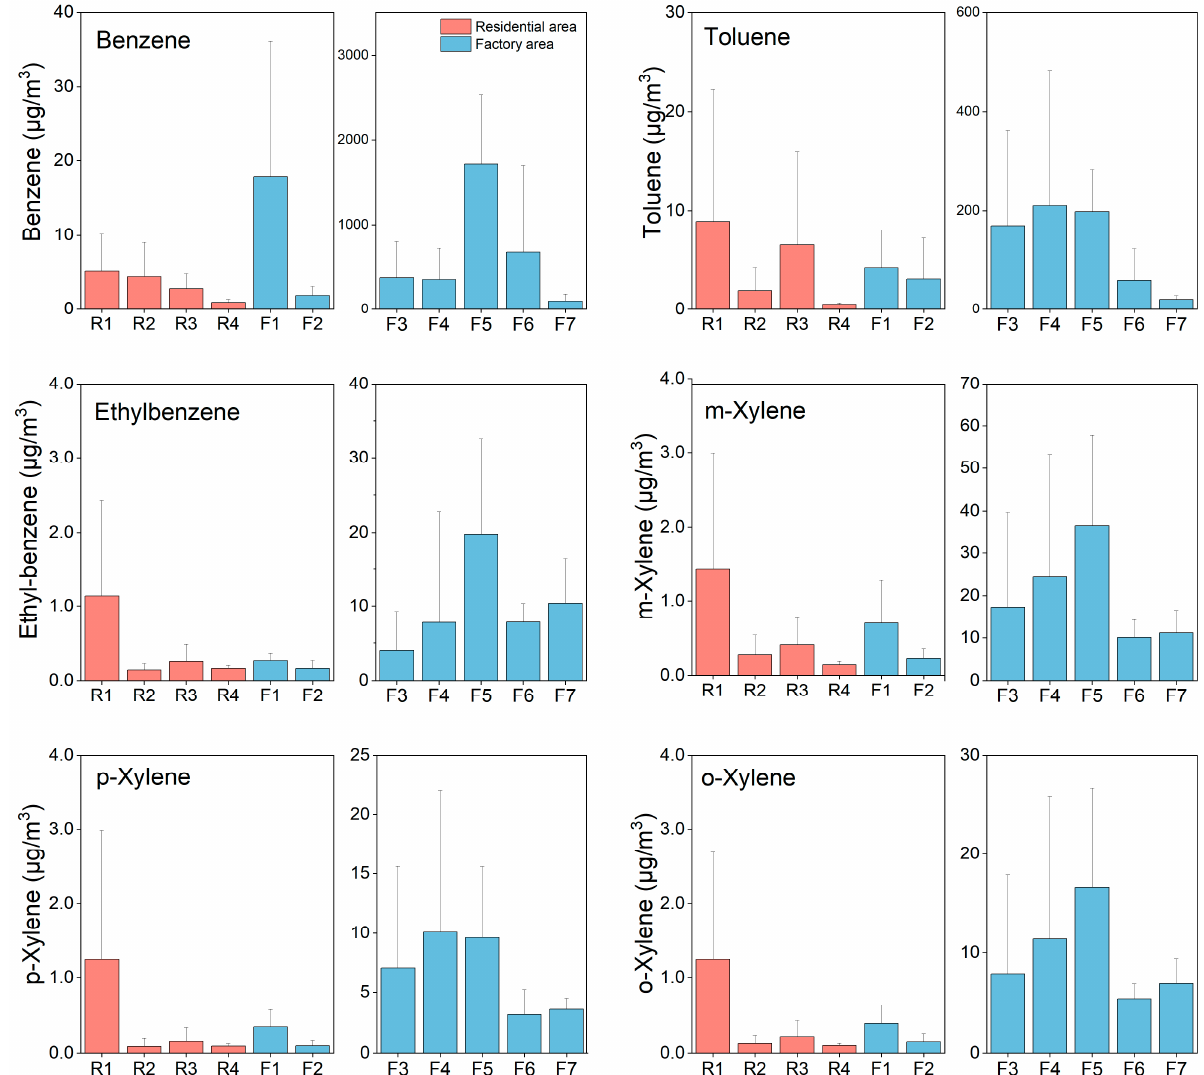
Figure 3. Atmospheric concentrations of benzene, toluene, ethylbenzene and xylenes in residential areas and at a coking factory. Red histograms represent the residential areas and blue ones represent sampling sites at the factory. Samples F1 and F2 were collected from two offices, F3 and F4 were from the top of two coke ovens in the factory. F5 to F7 were from chimneys, coal charging workshop and coke discharging workshop, respectively.